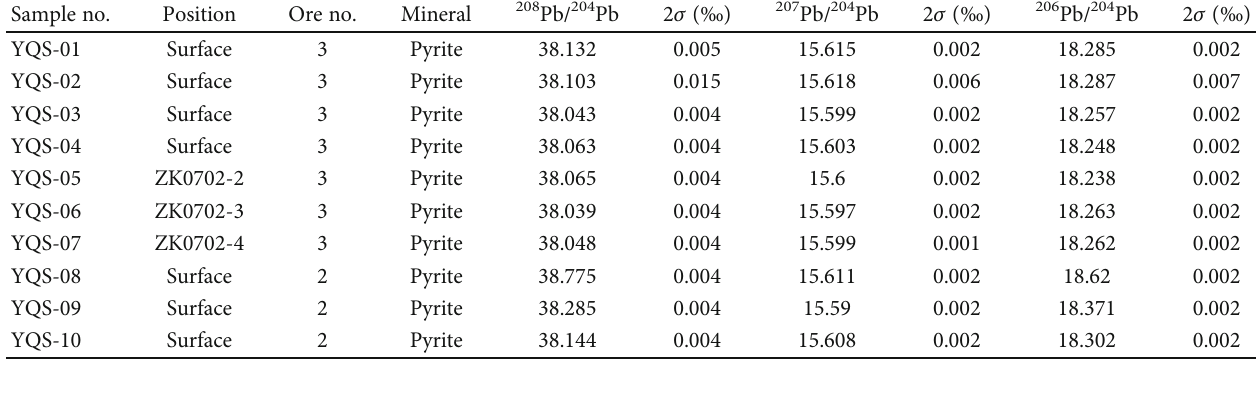
Table 4: Lead isotope ratios of ores in the Yuka gold deposit, reproduced from Chai et al. [77], (under the Creative Commons Attribution License/public domain). Sample no.